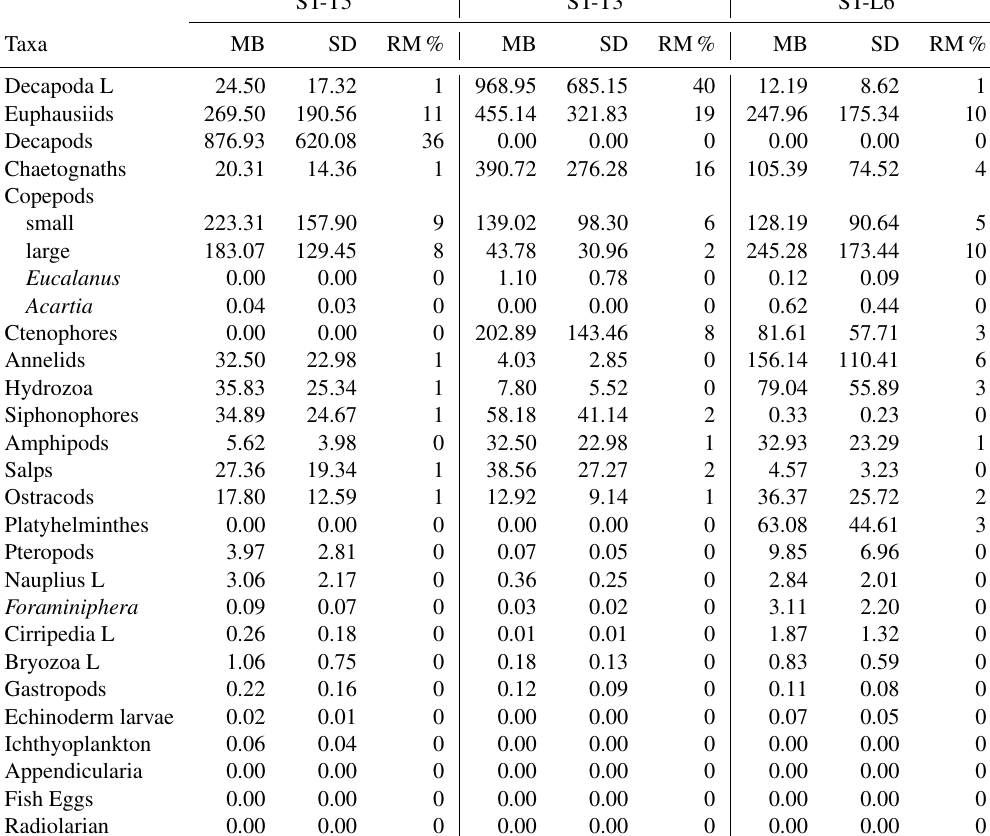
Table 3. Migrant biomass (mg Cm − 2 ) and rate of migration (RM) (%) for taxonomic groups of zooplankton sampled off northern Chile at three stations: off Iquique (Stations T5 and T3) and off Coquimbo (Station L6) during the austral spring 2015. RM represents the proportion (%) of migrant biomass with respect to total biomass found at night in the 0–90m for a given taxonomic group. SD is standard deviation of the migrant biomass estimated from n = 4 (Sts. T5 and T3) and n = 2 (St.